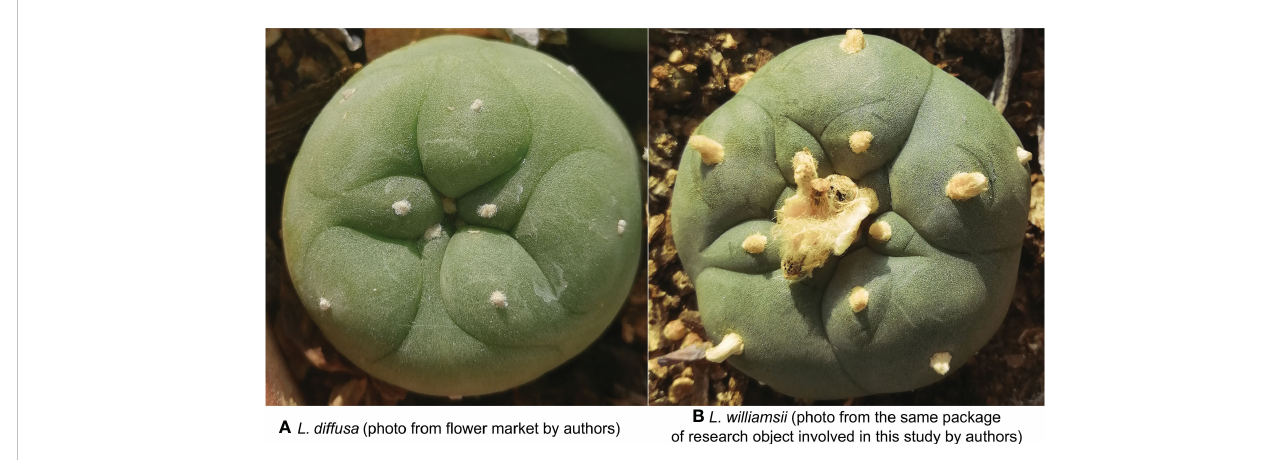
FIGURE 3 (A) Vertical view of Lophophora diffusa (photo from fl ower market by authors). (B) Vertical view of Lophophora williamsii (photo from the same package of research object involved in this study by